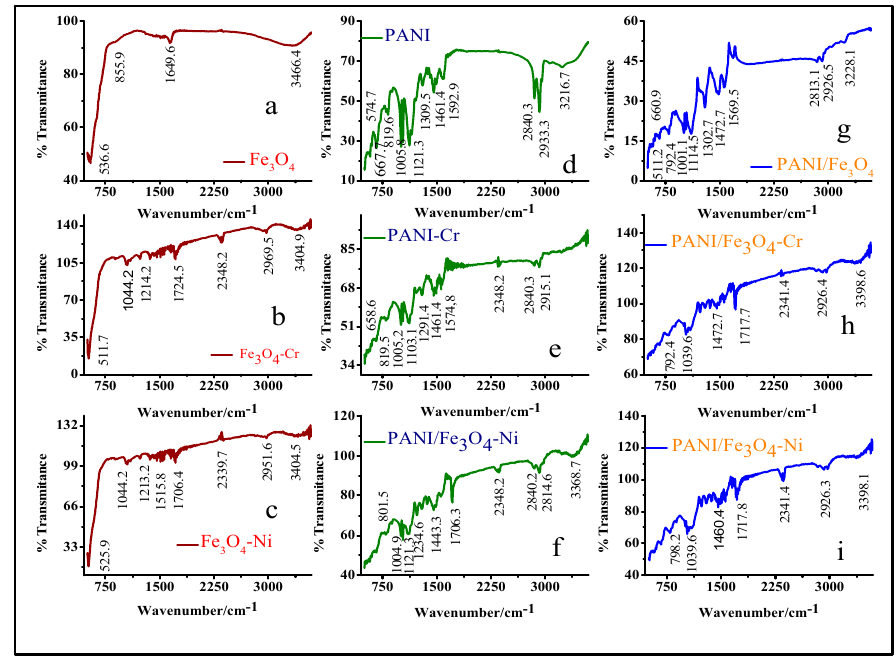
Figure 4. FTIR spectra of Fe 3 O 4 , PANI, and PANI / Fe 3 O 4 composites ( a , d , g ) before adsorption, ( b , e , h ) after Cr(VI) adsorption, and ( c , f , i ) after Ni(II) adsorption.